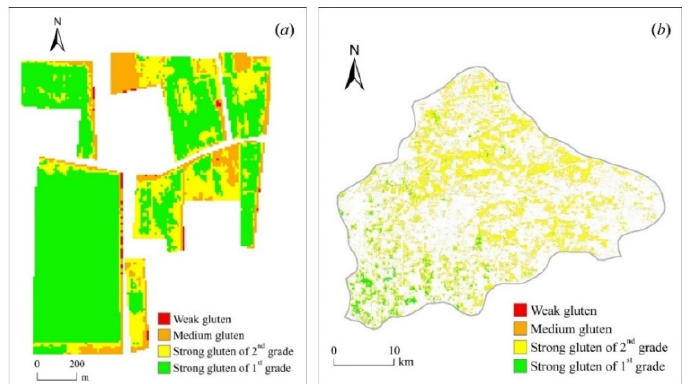
Figure 8. GPC spatial distribution maps of Xiaotangshan and Renqiu: ( a ) Xiaotangshan in 2019; ( b ) Renqiu in 2018. Table 6. Statistics of wheat area with different gluten types.